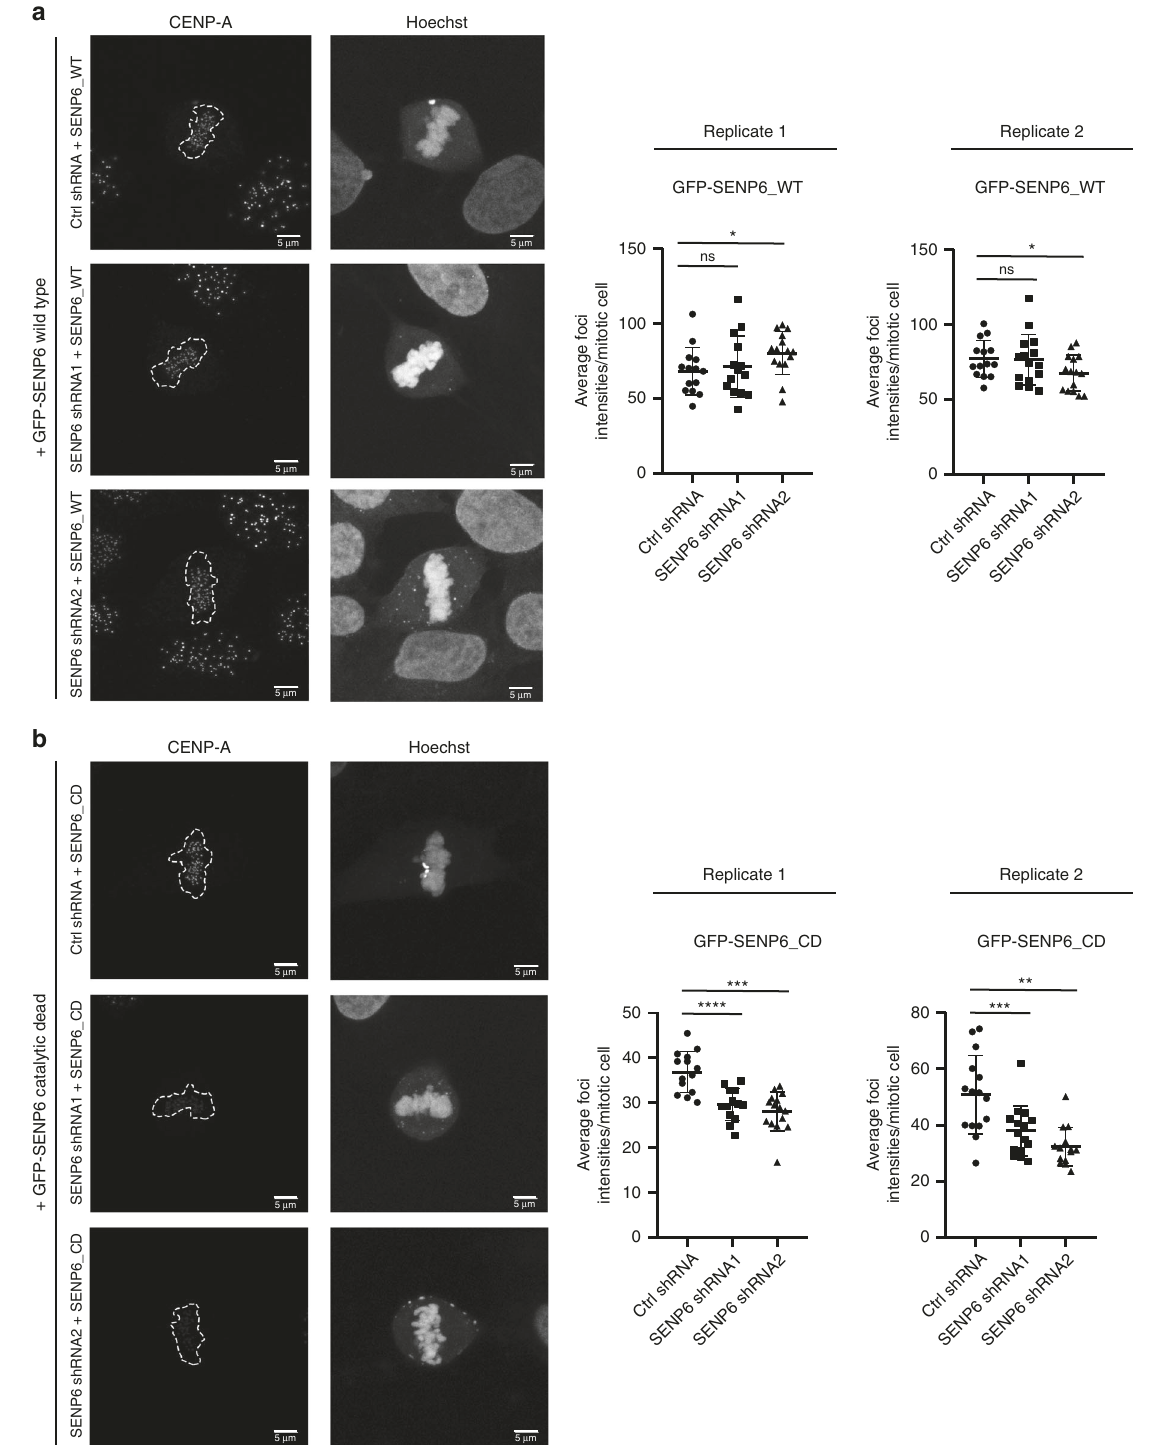
Fig. 7 CCAN protein localization at the centromere depends on catalytic activity of SENP6. Knockdown of SENP6 can be rescued by reintroduction of wild-type SENP6, but not by reintroduction of catalytic dead SENP6. a , b U2OS cells stably expressing inducible shRNA-resistant GFP-tagged wild type (WT) ( a ) or catalytic dead (CD) SENP6 ( b ) were established. Expression of these constructs was induced by doxycycline for 24h prior to transduction with lentiviruses encoding SENP6 shRNAs. Medium was replaced 1 day post infection. The next day, cells were seeded on coverslips and grown overnight. Subsequently, cells were fi xed and stained with Hoechst to visualize DNA and CENP-A antibody. Panels show representative pictures of mitotic cells. Scatter plots show quanti fi cations of the average CENP-A foci intensities per cell for two independent replicates. The data were statically analysed by two-sided t -test. * p <0.05; ** p <0.01; *** p <0.001, **** p <0.0001. For a replicate 1: n (ctrl shRNA) = 14 cells, n (SENP6 shRNA1) = 14 cells; n (SENP6 shRNA2) = 15 cells; replicate 2: n (ctrl shRNA) = 14 cells, n (SENP6 shRNA1) = 15 cells; n (SENP6 shRNA2) = 15 cells. For b replicate 1: n (ctrl shRNA) = 14 cells, n (SENP6 shRNA1) = 13 cells; n (SENP6 shRNA2) = 15 cells; replicate 2: n (ctrl shRNA) = 15 cells, n (SENP6 shRNA1) = 15 cells; n (SENP6 shRNA2) = 14 cells. Dashed lines indicate areas of DNA. Scale bars = 5 µ m. Error bars represent standard deviation. Source data are provided as a Source Data fi